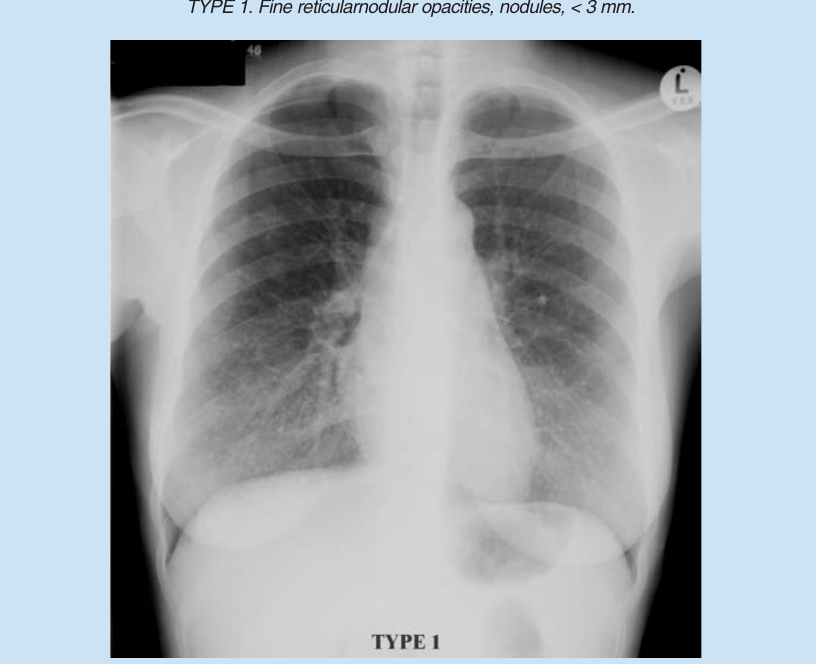
Fig. 2. Fifty-year-old female patient, relatively well, with a non-productive cough of some months’